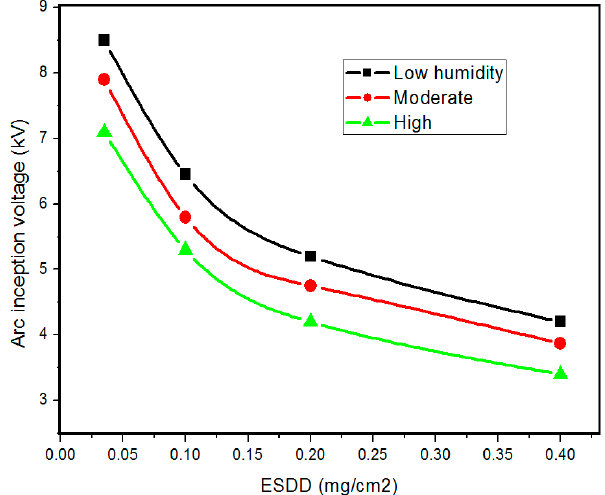
Figure 7. Arc inception voltage at different humidity levels, where pollution distribution = uniform, NSDD = 0.75 mg/cm 2 , temperature = 10 °C, and standard deviation = 2.8%–6.1%.